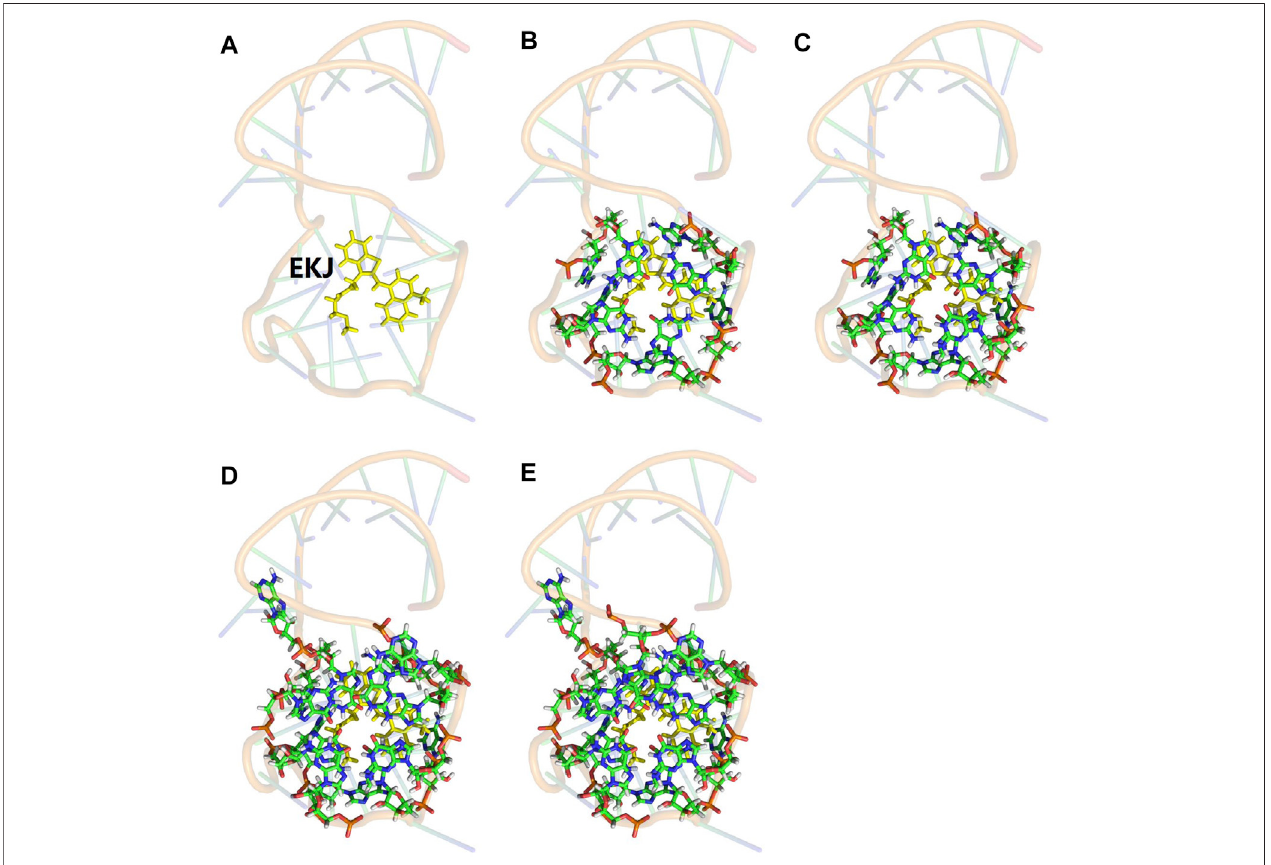
FIGURE 2 | Illustration of the model system for the truncated full-system QM calculation. The QM subsystem was shown in sticks, and the MM subsystem was shown in 80% transparency backbone. (A) The one-body QM calculation in the EE-GMFCC method for such a system is only for fl uorophore EKJ (shown in yellow). (B) Fullsys (4) which was constructed with a prede fi ned distance threshold of λ FS (cid:2) 4 Å, (C) fullsys (5) ( λ FS (cid:2) 5 Å), (D) fullsys (6) ( λ FS (cid:2) 6 Å), and (E) fullsys (7) ( λ FS (cid:2) 7 Å), respectively.